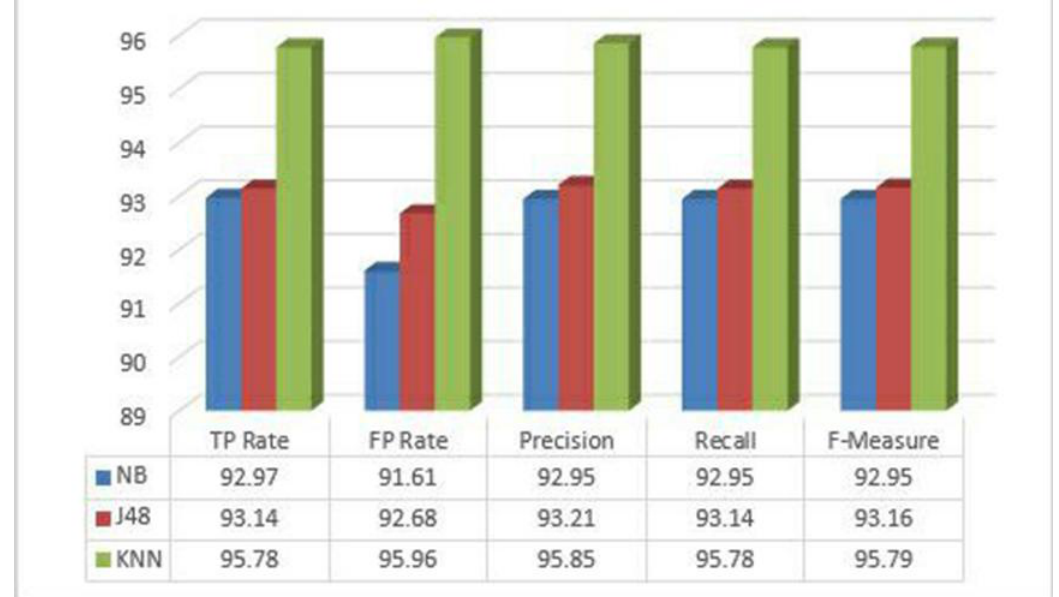
Figure 7. Details of the results of the three